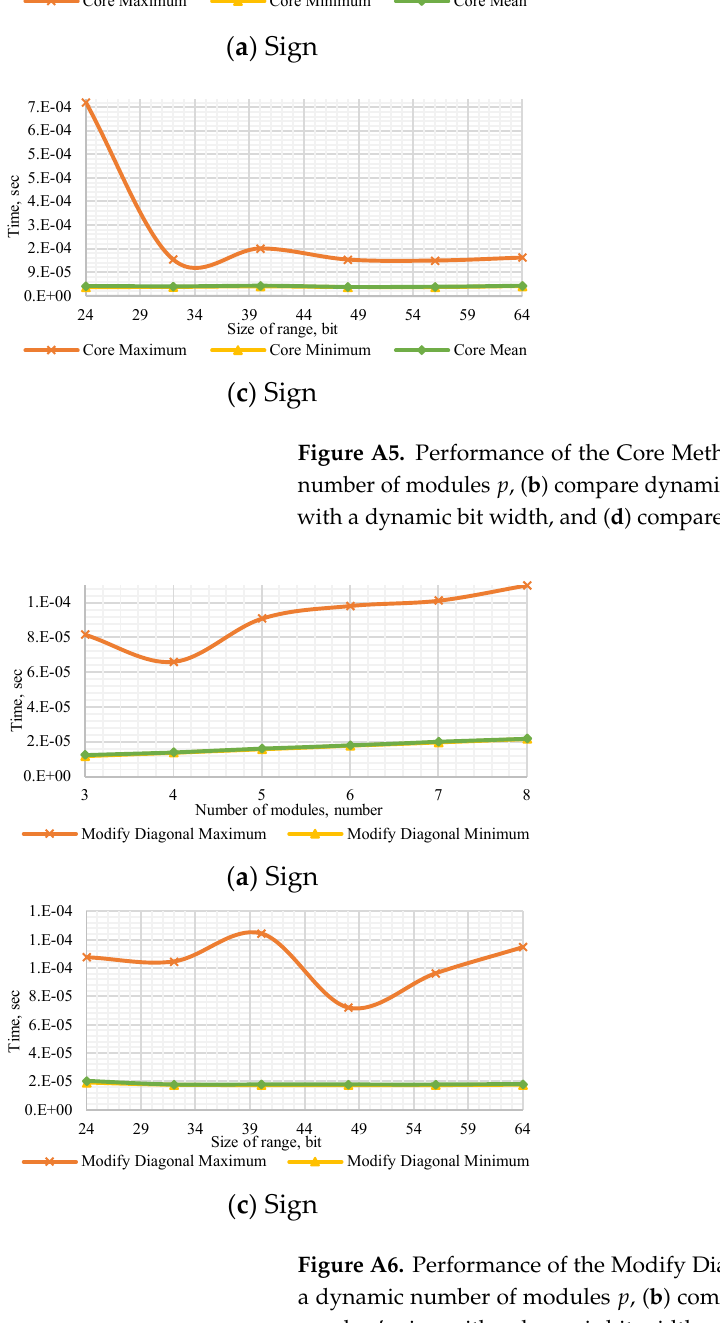
( d ) Comparison Figure A3. Performance of the Approximate Method to ( а ) determine the number’s sign with a dy- namic number of modules (cid:1868) , ( b ) compare the dynamic number of modules (cid:1868) , ( c ) determine the number’s sign with a dynamic bit width, and ( d ) compare numbers with dynamic bit width. ( a ) Sign ( b ) Comparison